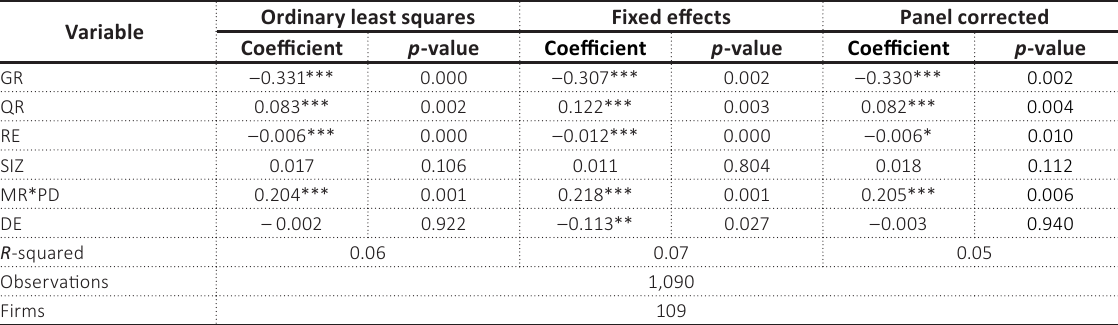
Table 6. Results for equation (2)